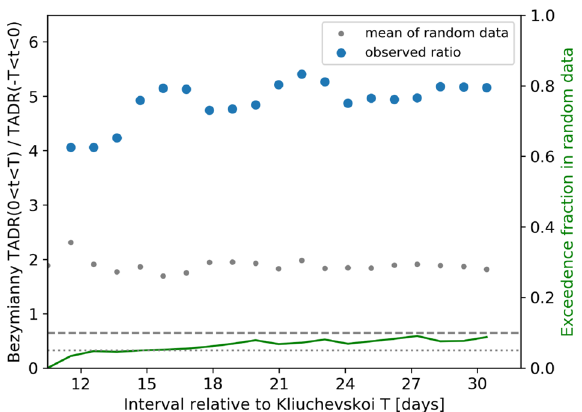
Figure 8. (Left Axis) Ratio between the averaged Bezymianny TADR values within T days after and before the Klyuchevskoy eruptions (#1–6). (Right axis). Mean fraction in randomized data that exceed the observed ratio (see the text for more